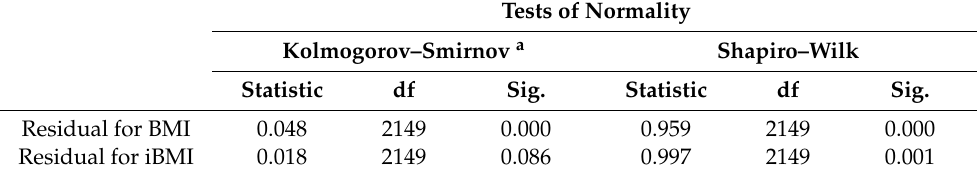
Table 3. Normality Table 3. Normality Data.